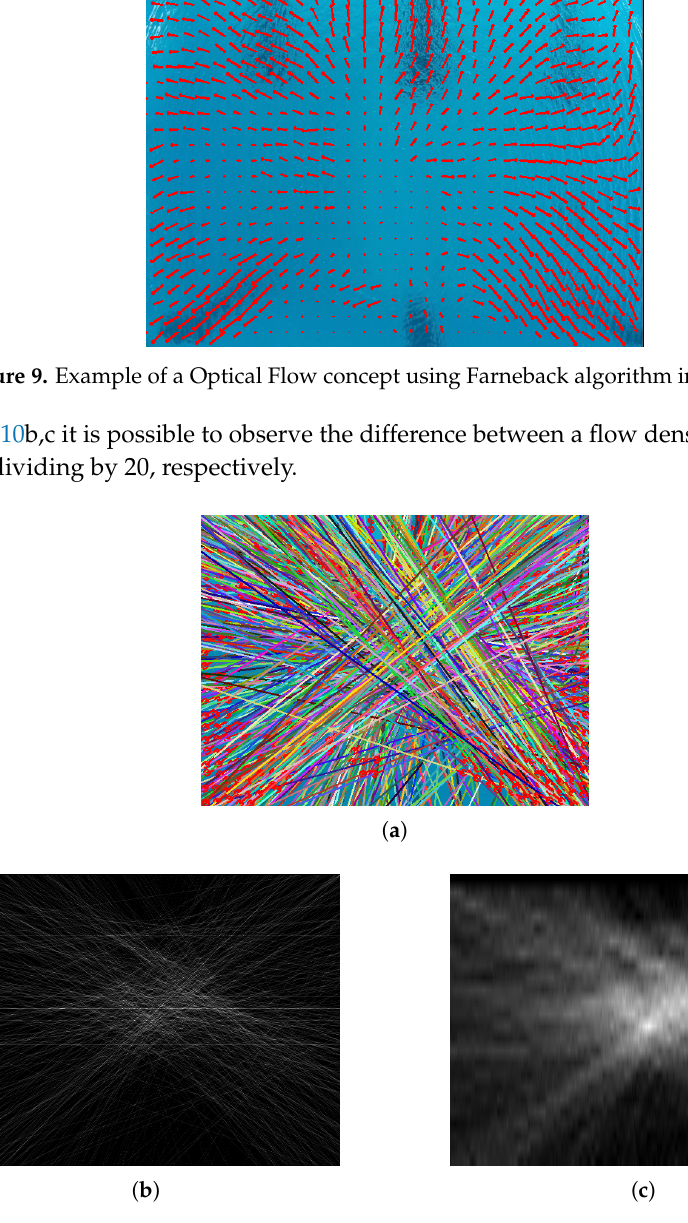
Figure 10. ( a ) Linear equations after flow texture extraction; ( b ) Flow density without dividing by 20; ( c ) Flow density dividing by